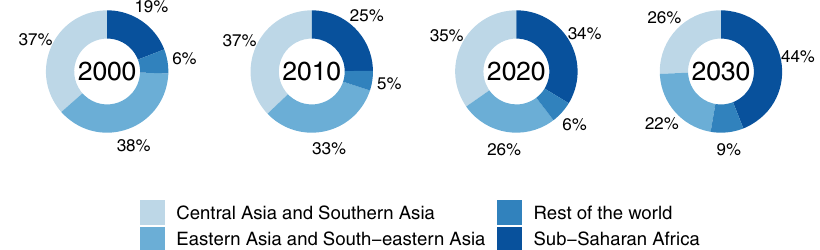
Fig. 5 Regional breakdown of the global population mainly using polluting fuels for cooking. Estimated (posterior median) regional populations mainly using polluting fuels as a proportion of the estimated (posterior median) overall global population mainly using polluting